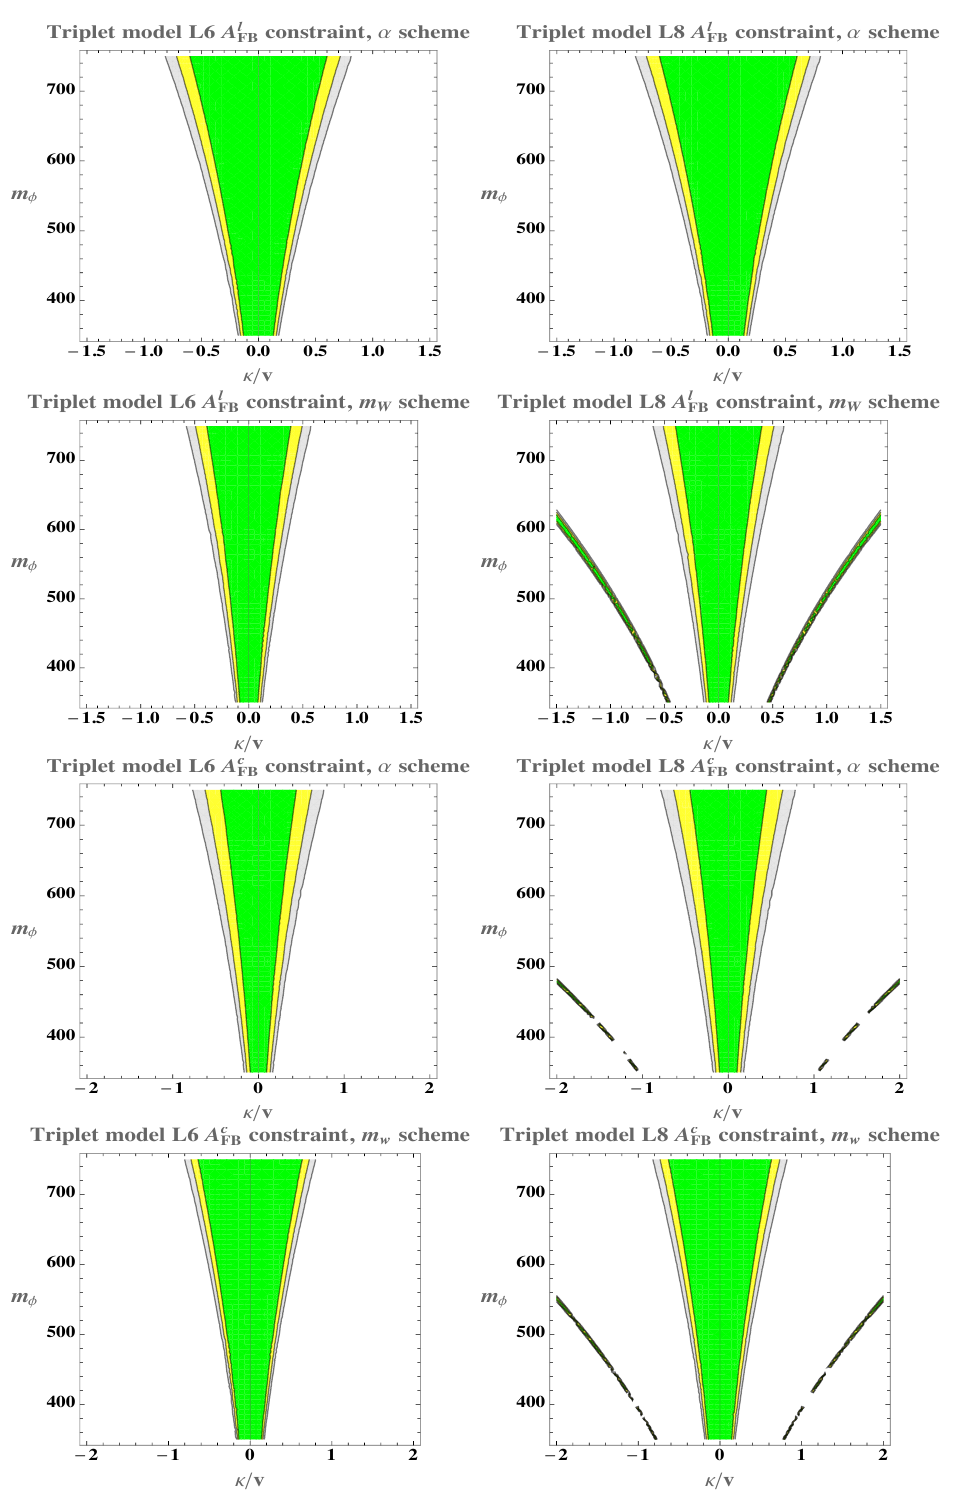
Figure 11 . Shown are the constraints on the model space from the A ‘